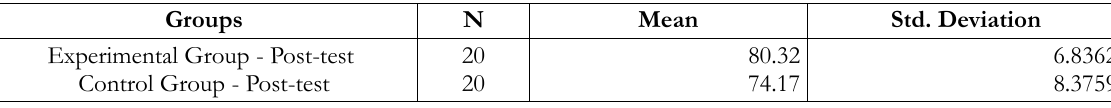
Table 3. The Mean and Standard Deviation of the Post-test of Experimental and Control